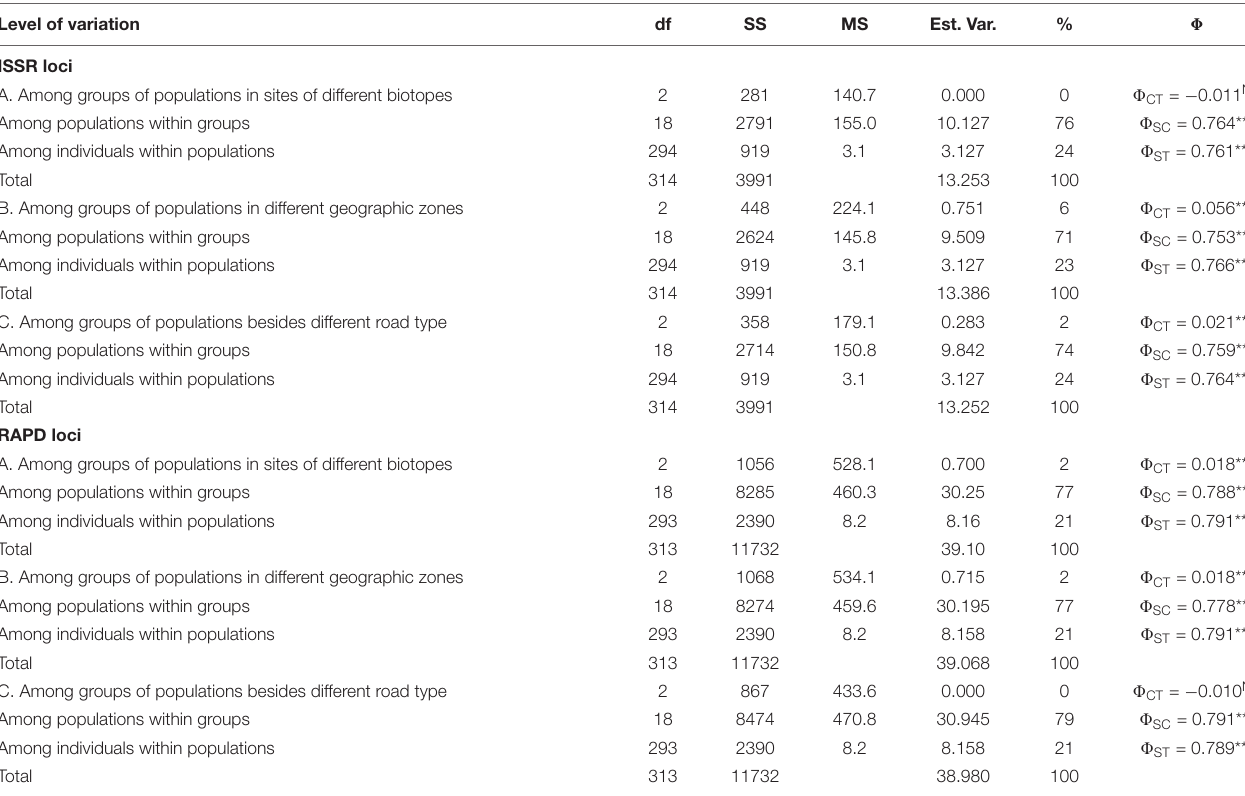
TABLE 2 | ISSR and RAPD loci based hierarchical analyses of molecular variance (1) among groups of populations differing in biotope (A), geographic zone (B), type of neighboring road (C); (2) among populations within groups, and (3) within populations of Impatiens parviflora. Level of variation df SS MS Est. Var.